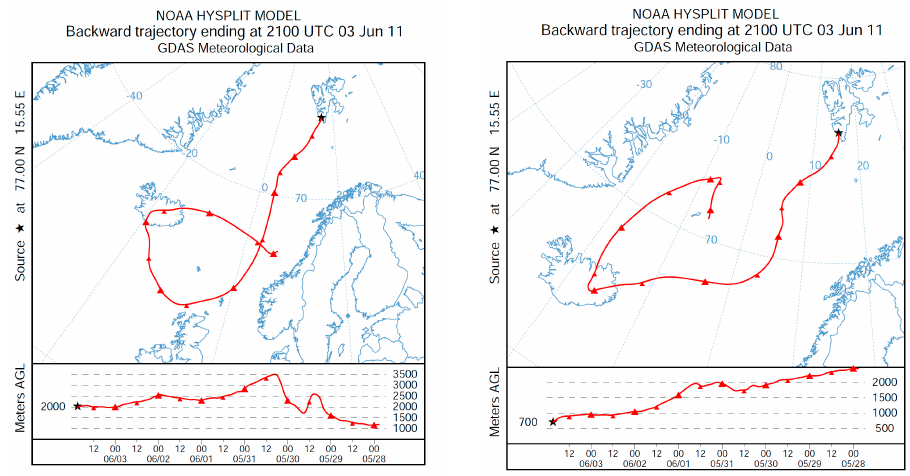
Figure 10. Trajectories of air masses inflow in the region of Polish Polar Station at Hornsund fjord during Grímsvötn eruption in 2011.